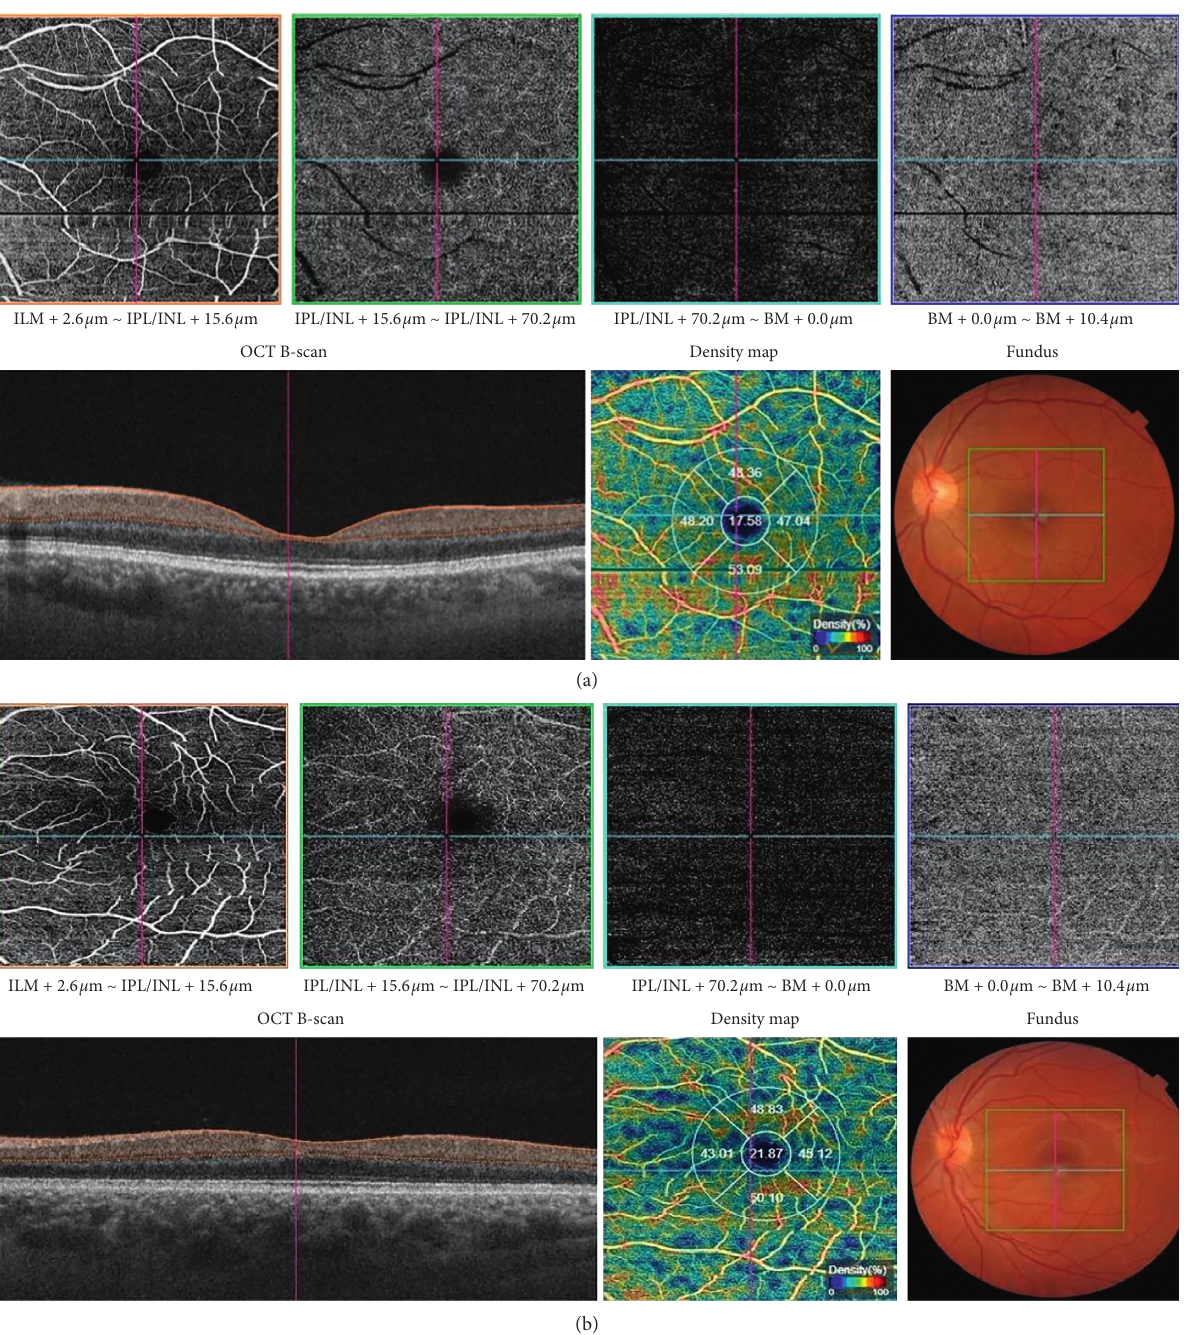
Figure 1: The measurements of foveal and parafoveal vessel density in a (a) patient with inactive GO and (b) control